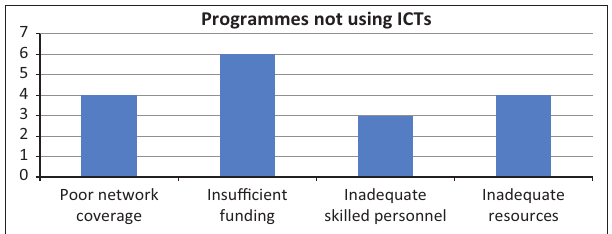
01234567 FIGURE 2 : Barriers to the use of information and communication technologies in HIV/AIDS management programmes ( N = 20).